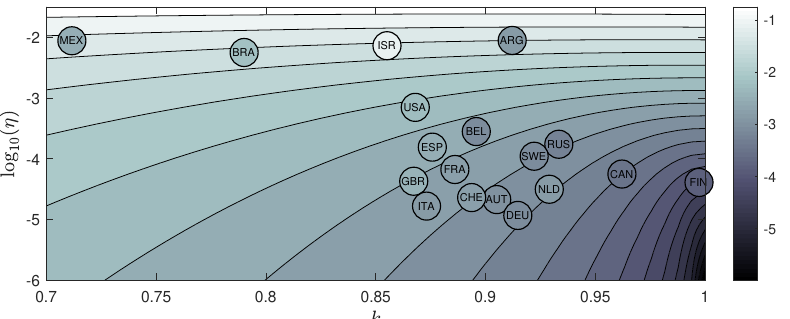
Figure 10. Same as Figure 4 but using another colormap, where countries have been added. The ( b c ) , shown as function of k and η . Circles for countries have been placed brightness represents log 10 at positions k and η according to Table 1, and the brightness of a filled circle corresponds to the reduced vaccination rate b , also taken from Table